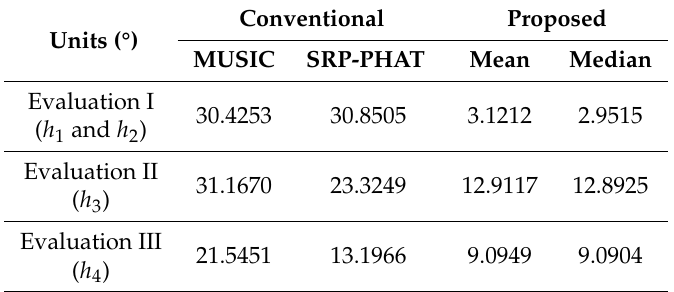
Table 3. Direction of arrival (DOA) error depending on sound localization